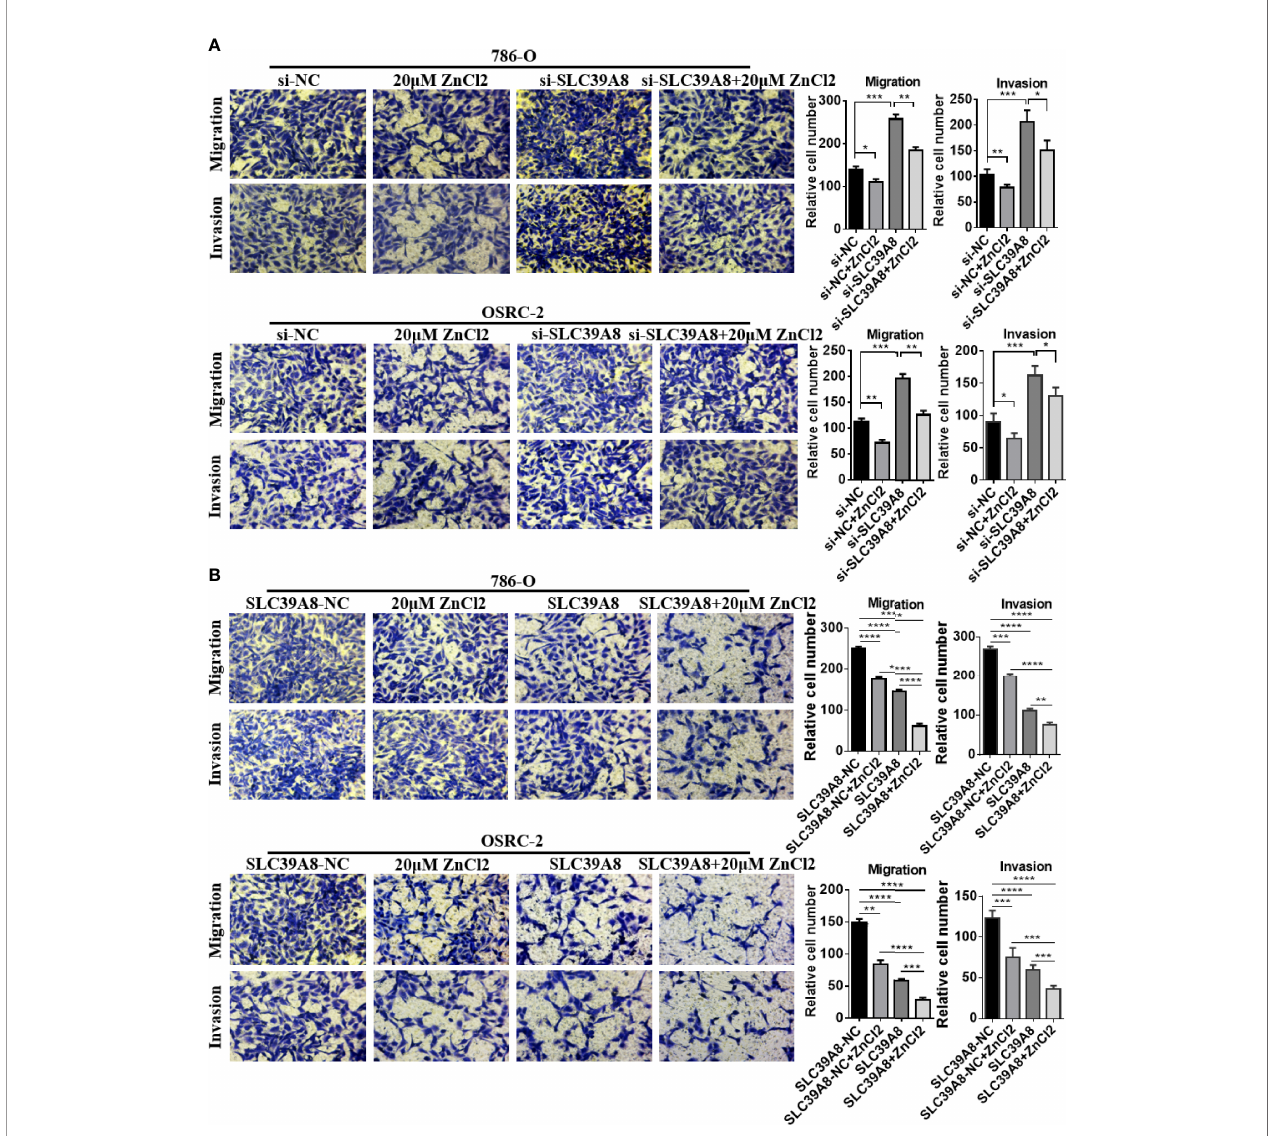
FIGURE 6 | SLC39A8/zinc inhibits the invasion and migration of ccRCC cells in vitro . (A) Representative images of migration and invasion assays of SLC39A8 knockdown-786-O and OSRC-2 cells. (B) Representative images of migration and invasion assays of SLC39A8 overexpressed-786-O and OSRC-2 cells. Four microscopic fi elds with ×200 magni fi cation were randomly selected for cell counting, and the data were presented as the mean ± standard deviation. *P < 0.05, **P < 0.01, ***P < 0.001, ****P <